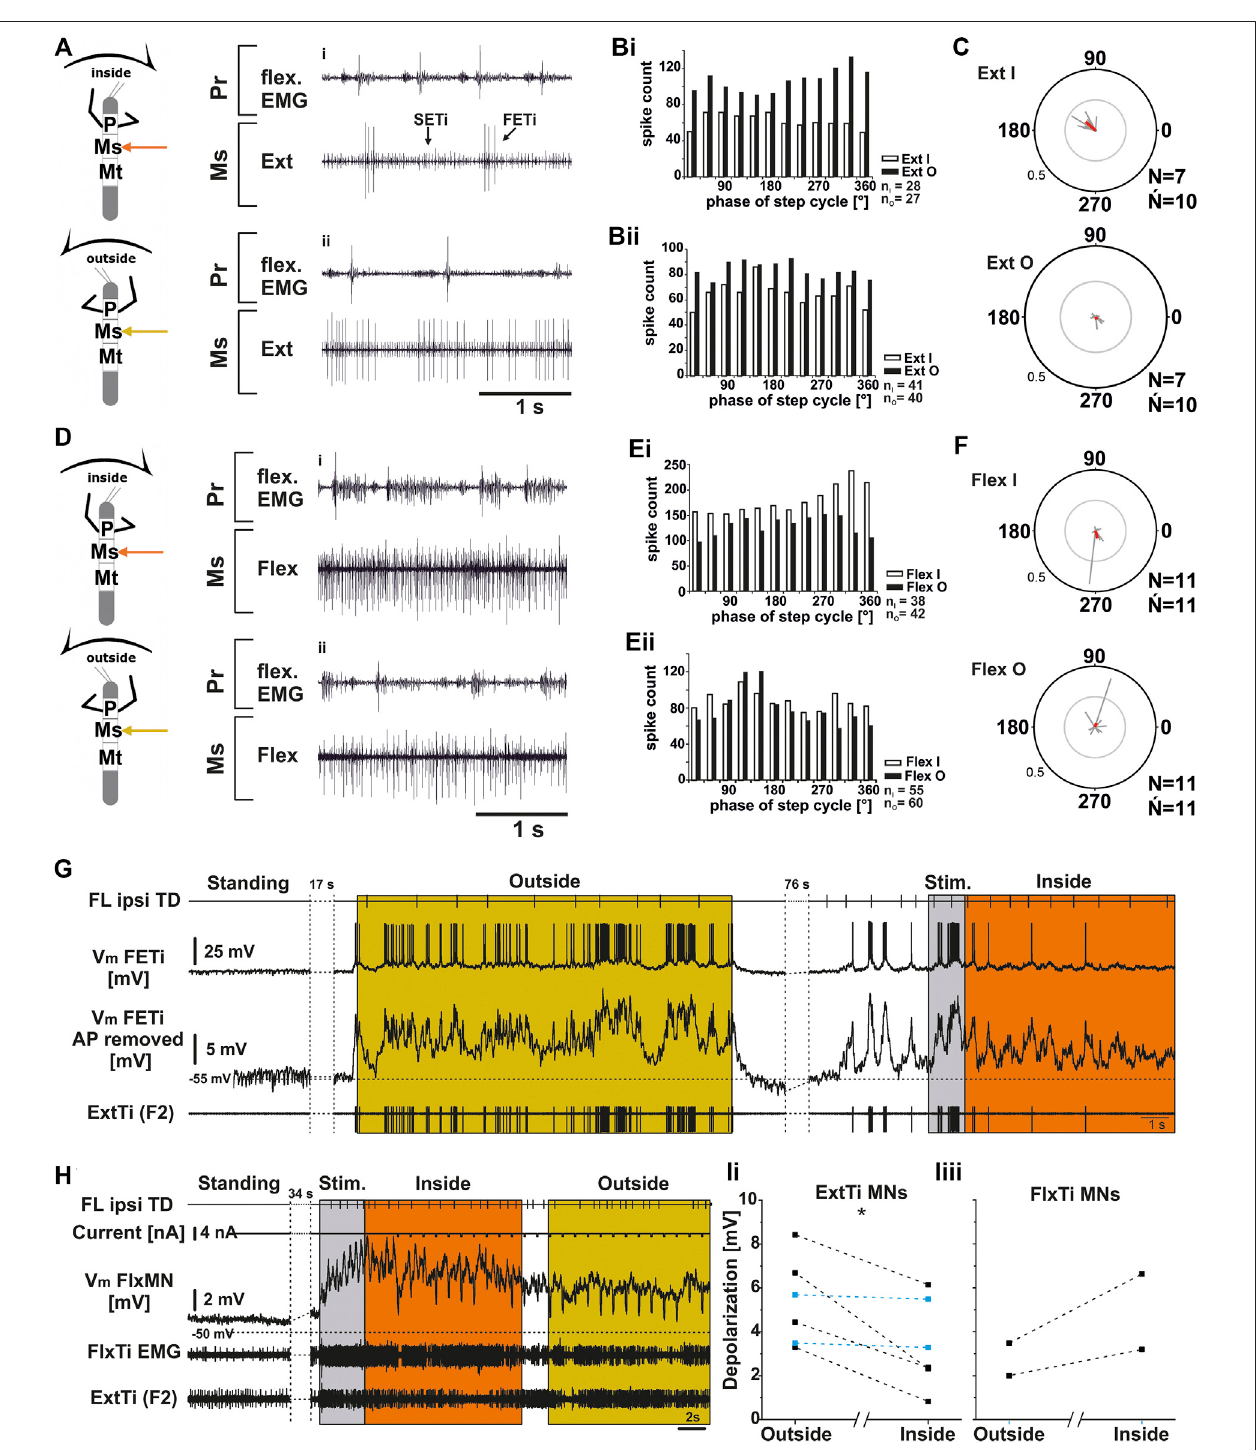
FIGURE 5 | Mesothoracic extensor (A – C) ; (G,Ii) and fl exor tibiae (D – F; H,Iii) MN output in the deafferented ganglion during front leg (FL) inside and outside stepping. (A) fl exorEMG ofthefront leg (top trace and third trace), together withextracellular recordings oftheipsilateral mesothoracicextensor nerve (nl3) during inside (i) and outside (ii) stepping sequences; (Bi,Bii) . Phase histograms of extensor nerve activity from the experiment shown in A (Bi) , and an additional experiment to show variabilitybetweenexperiments (Bii) ,comparinginsideandoutsideactivityinthesameanimalwithrespecttoFLstepcycle. (C) Polarplotswithspikeeventmaxima (greyvectors)andtheirmean(red)fortheextensorwithrespecttoFLstepcycleduringinside(top)andoutside(bottom)stepping; (D) fl exorEMGrecordingoftheFL(top trace and third trace), together with extracellular recordings of the ipsilateral mesothoracic fl exor nerve (ncr) during an exemplary inside (i) and outside (ii) stepping